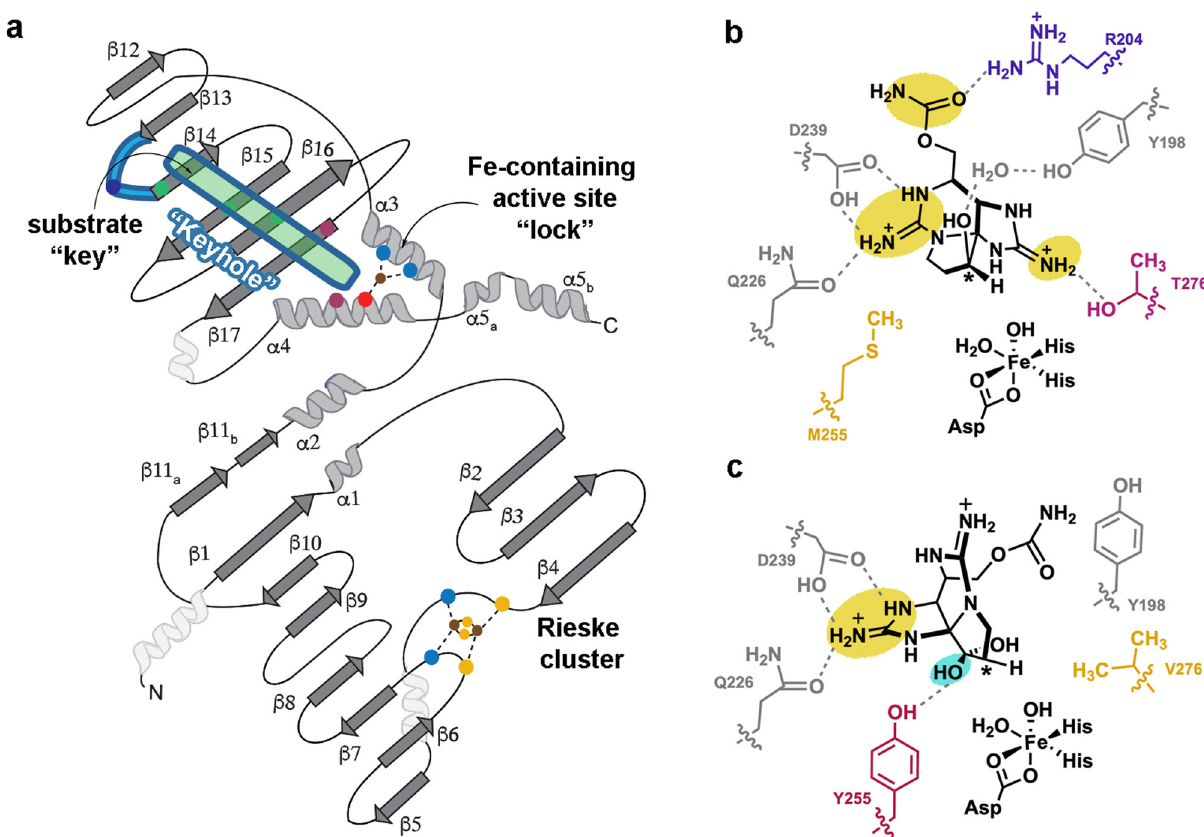
Fig. 6 A coordinated interplay of three protein regions in SxtT is important for dictating selectivity. a A topology diagram of SxtT/GxtA. The active site (dark pink circles represent residues 255 and 276), loop region (light blue, the dark blue circle represents residue 204) and tunnel (green, green circles represent residues at the 214, 232, and 237 positions) each have residues that are involved in dictating selectivity. The so-called “ keyhole ” (loop and tunnel region) of these proteins is outlined in blue. The secondary structure that is conserved among the structurally characterized α 3 Rieske oxygenases is shown in dark gray and light gray 5 . The three helices in white are not conserved. b Three regions of β -STOH that are also found in STX are recognized by SxtT (yellow): the carbamate is recognized by Arg204 from the fl exible loop and the guanidium ions are recognized by active site residues Thr276, Gln226, and Asp239. Of these residues, only Thr276 and Arg204 are unique to SxtT. c Two regions of STX are recognized by active site residues in GxtA: the guanidinium moiety of the fi ve-membered ring interacts with Gln226 and Asp239 and the α -hydroxyl interacts with Tyr255. Of these recognition points, only the α -hydroxyl (teal) is unique to STX and only Tyr255 is unique to